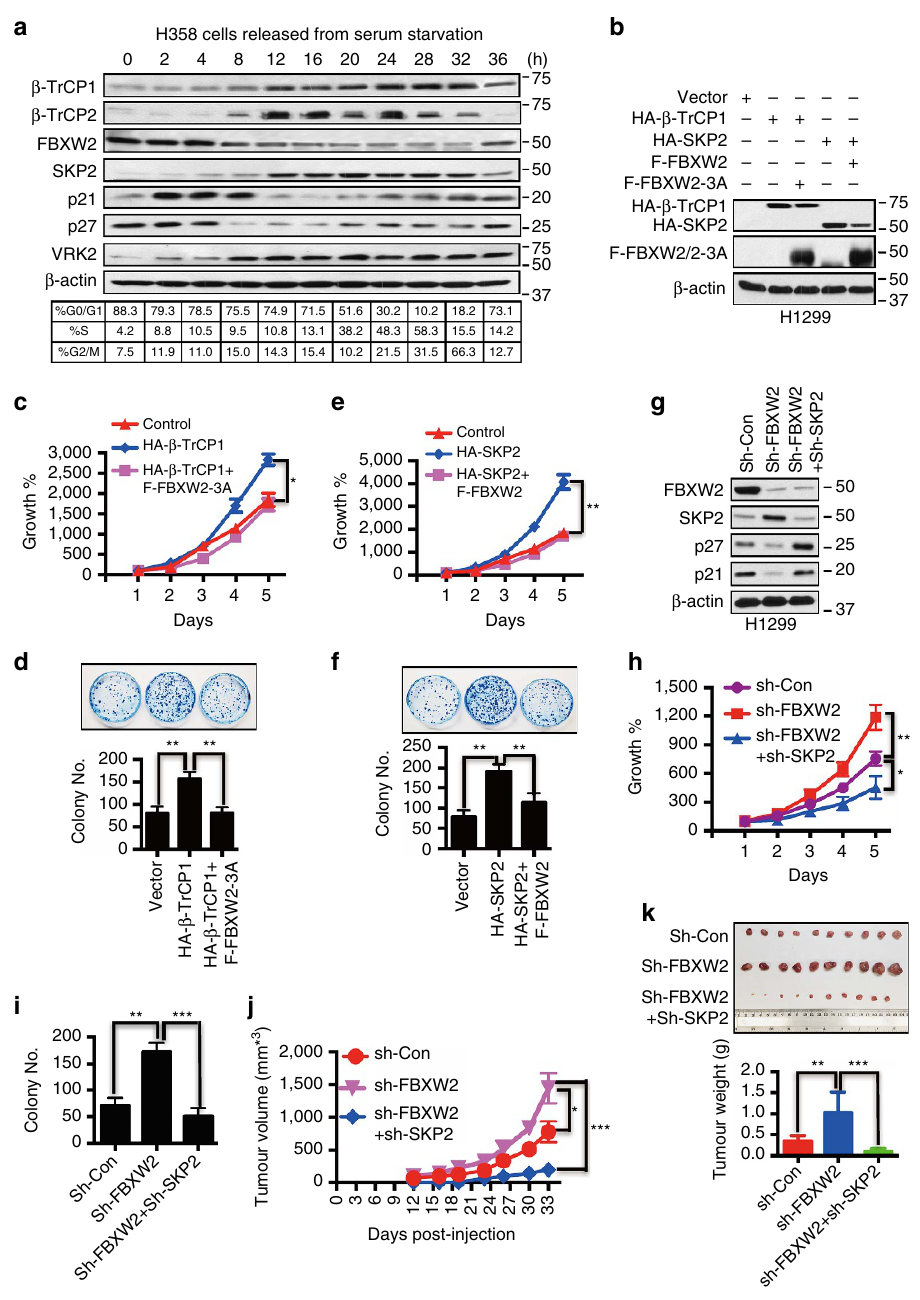
Figure 5 | FBXW2 mediates the biological effects of b -TrCP1 as a downstream effector and of SKP2 as an upstream modulator. ( a ) Fluctuation of the levels of F-box proteins and VRK2 kinase during cell cycle progression: H358 cells were serum starved for 48h, followed by serum addition. Cells were harvested at indicated time points and subjected to FACS and IB analyses using indicated Abs. ( b – f ) FBXW2-3A mutant rescues growth-promoting phenotype induced by b -TrCP1 overexpression ( b – d ), and wt FBXW2 rescues growth-promoting phenotype induced by SKP2 overexpression ( b , e , f ): H1299 cells were co-transfected with the indicated plasmids, followed by IB ( b ), ATP-lite proliferation assay ( n ¼ 3) ( c , e ) and clonogenic survival assay ( n ¼ 3) ( d , f ). Shown is mean ± s.e.m. Student’s t -test was performed, * P o 0.05; ** P o 0.01. ( g – i ) FBXW2 depletion stimulates cell growth, which is abrogated by simultaneous SKP2 depletion: H1299 cells were transfected with shRNAs targeting FBXW2 alone or in combination with shRNA targeting SKP2, along with scramble control, and then harvested for IB ( g ), ATP-lite proliferation assay ( n ¼ 3) ( h ) and clonogenic survival assay ( n ¼ 3) ( i ). Shown is mean ± s.e.m. Student’s t -test was performed, * P o 0.05; ** P o 0.01; *** P o 0.001. ( j , k ) FBXW2 depletion stimulates tumour growth, which is abrogated by simultaneous SKP2 depletion: H1299 cells were transfected with shRNAs targeting FBXW2 alone or in combination with shRNA targeting SKP2, along with scramble control, followed by injection (1 (cid:2) 10 6 cells) into nude mice. Tumour growth was observed for 33 days ( j ). Tumours were then harvested, photographed and weighted ( k ). Shown is mean ± s.e.m. Student’s t -test was performed, * P o 0.05; ** P o 0.01; *** P o b -TrCP1 or SKP2 had a statistically significantly poorer survival not shown). In contrast, patients with high FBXW2 mRNA levels rate, whereas those with low mRNA levels of b -TrCP1 or SKP2 had a significantly better survival rate than those with low levels had a better survival rate (Supplementary Fig. 6f,h and data (Supplementary Fig. 6g and data not shown), further